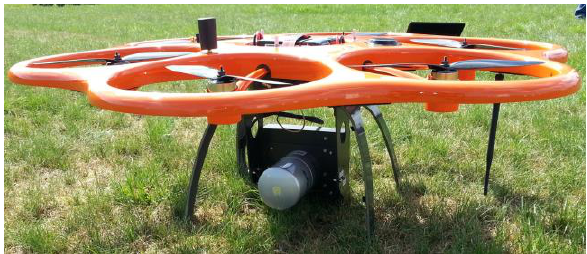
Figure 2. Unmanned Aerial System used to collect LiDAR data